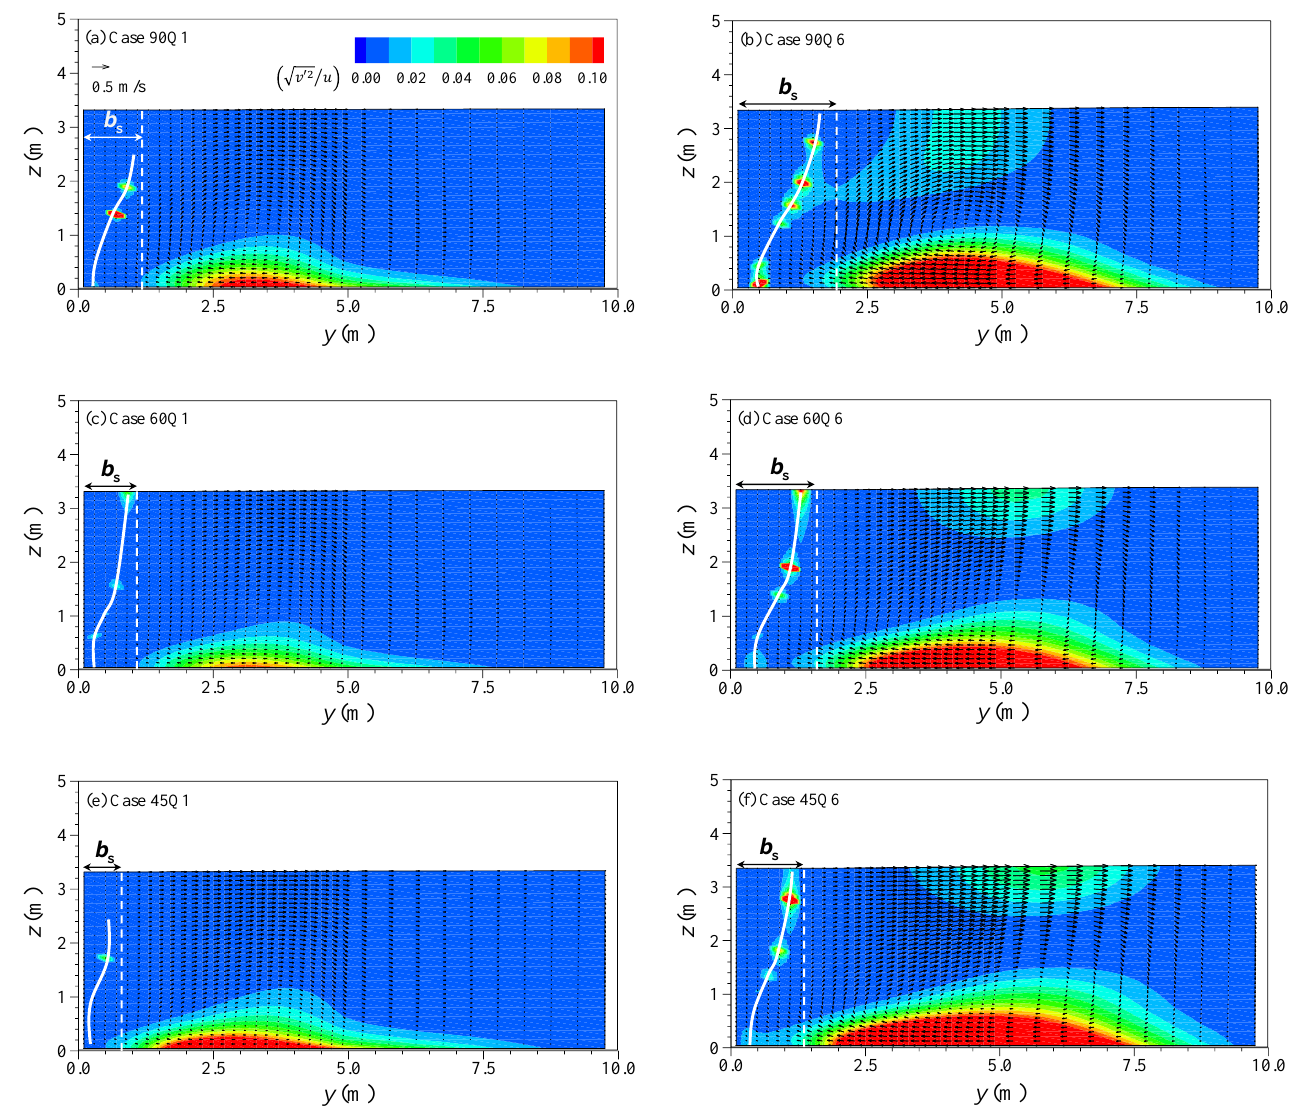
(cid:112) v (cid:48) 2 / u ) in transverse